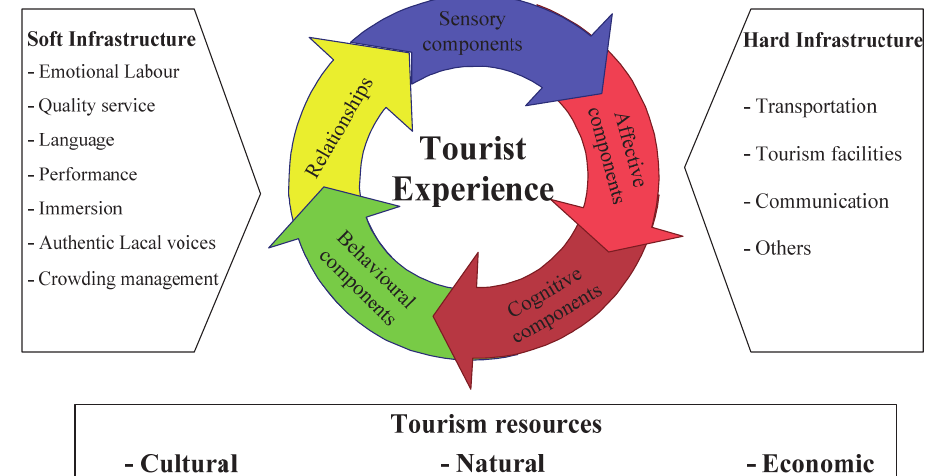
Fig. 1. The overall interplay of soft and hard infrastructure forces affecting tourists’ experiences (Pearce & Wu,